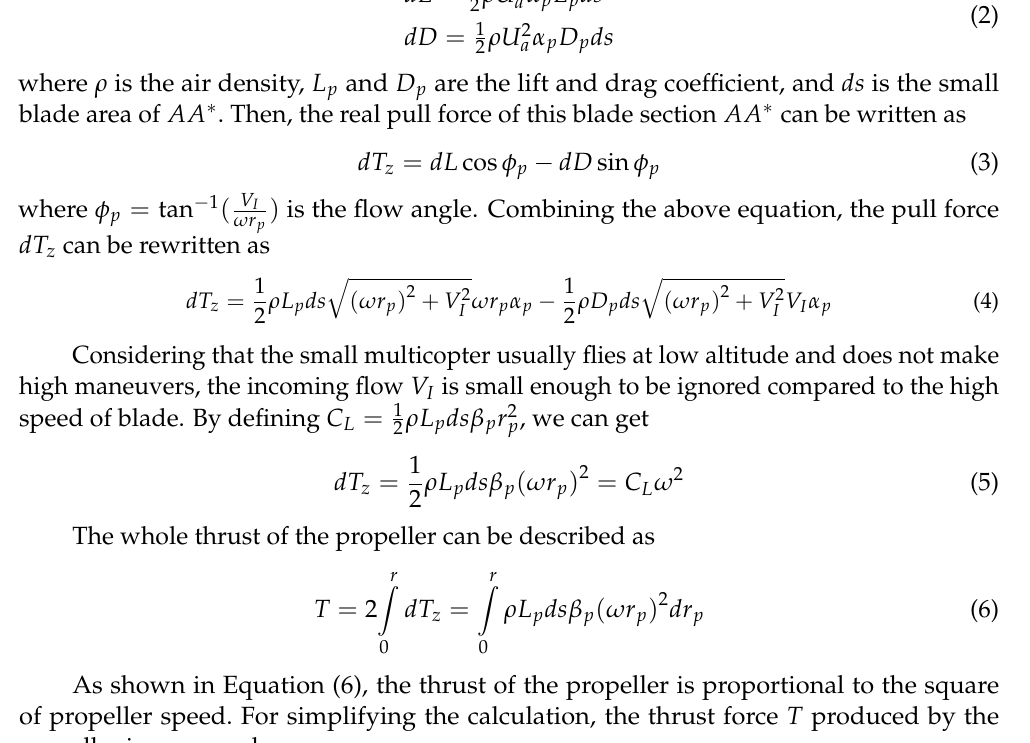
Figure 2. The profile of propeller.